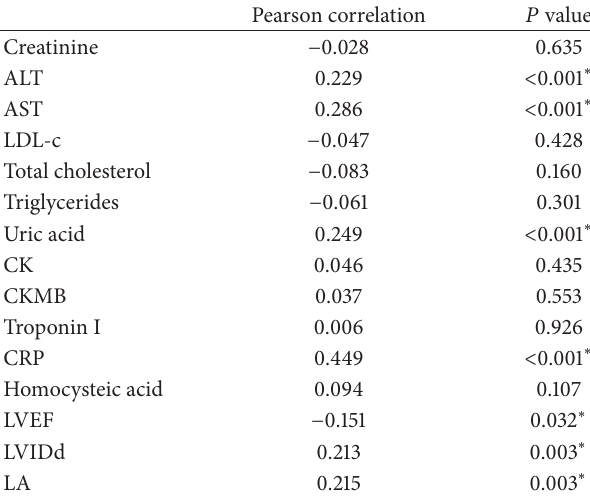
Table 2: Linear correlation between ceruloplasmin and other parameters.